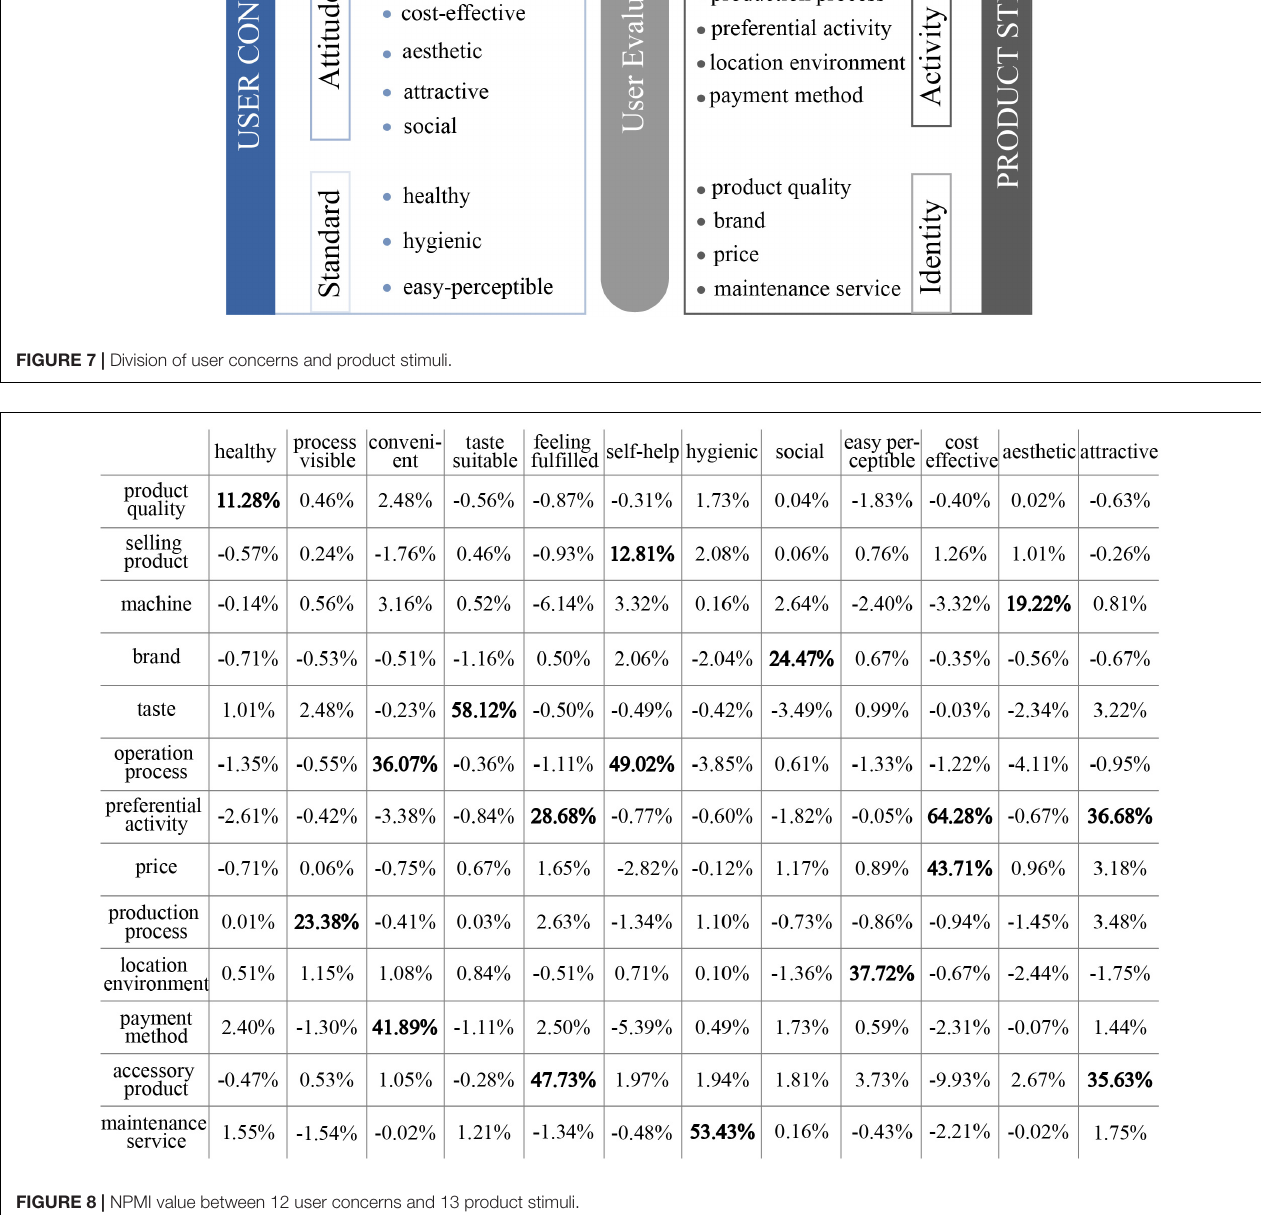
FIGURE 8 | NPMI value between 12 user concerns and 13 product